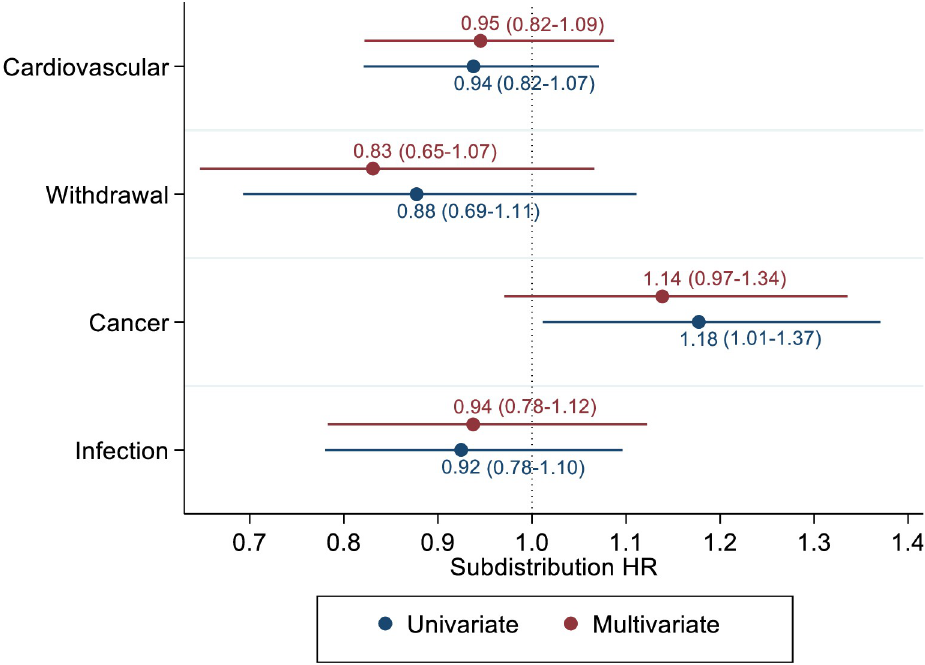
Fig 2. Univariate and multivariate competing risk analysis of cause-specific patient mortality between O and non- O ABO group. The estimates show the subdistribution hazards ratio for ABO O group where non-O ABO group is the reference